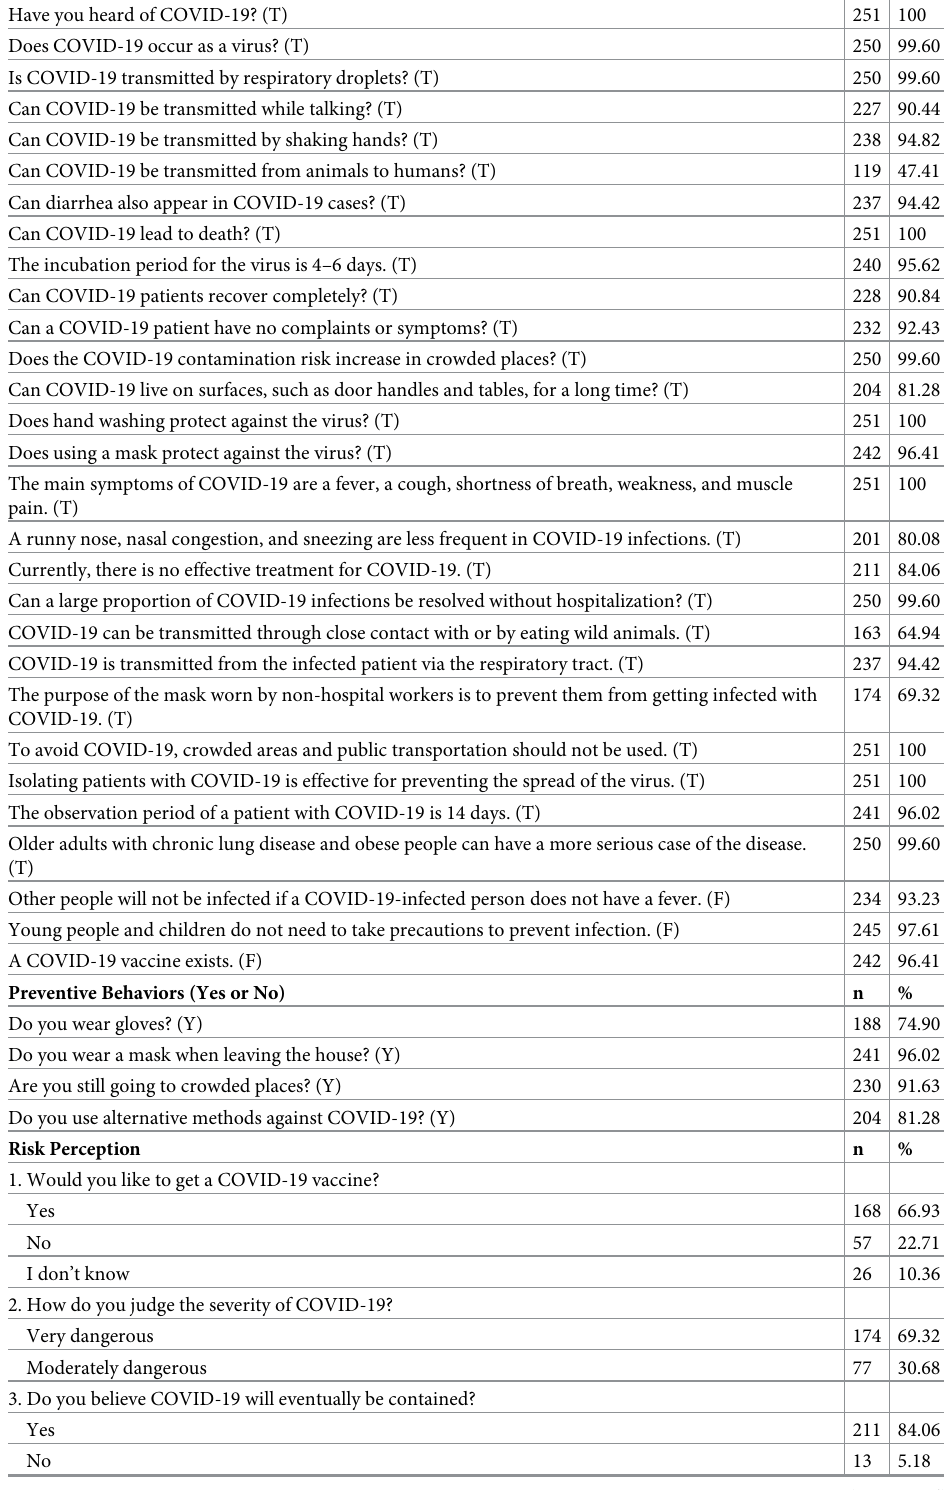
Table 2. Correct answers to questions on knowledge, preventive behaviors, and risk